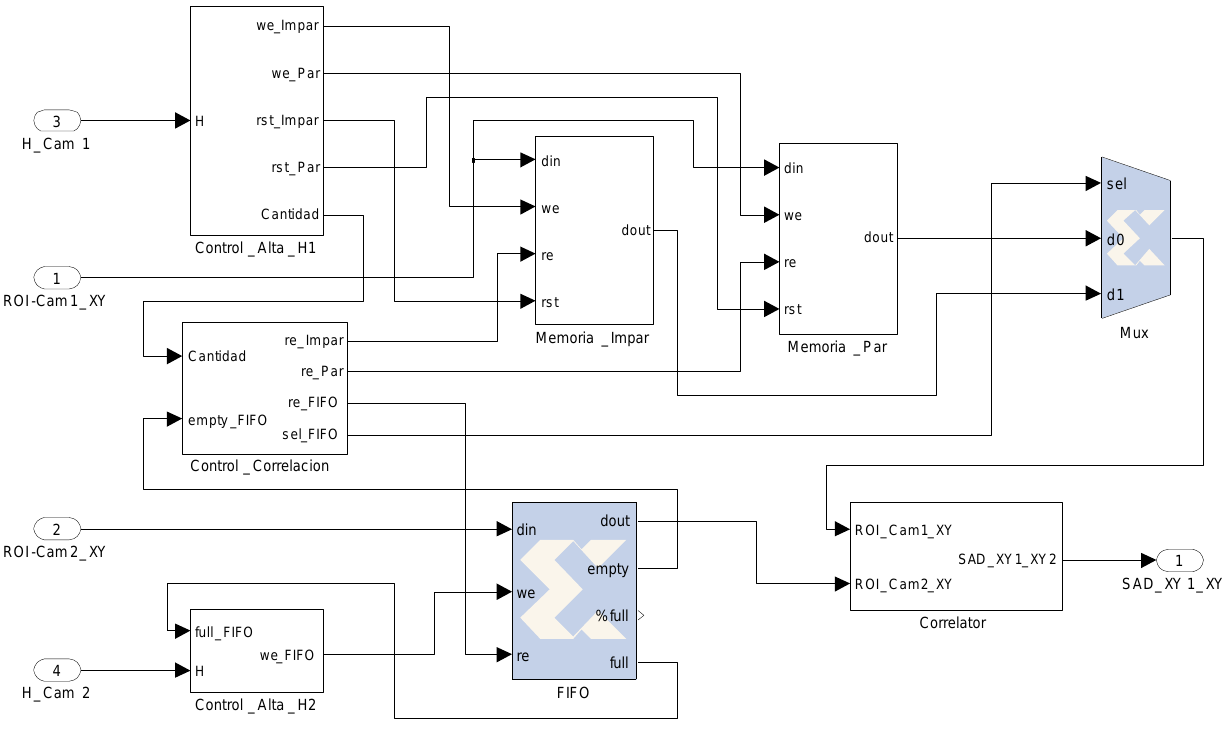
Figure 8. Control data flow to introduce data to correlator